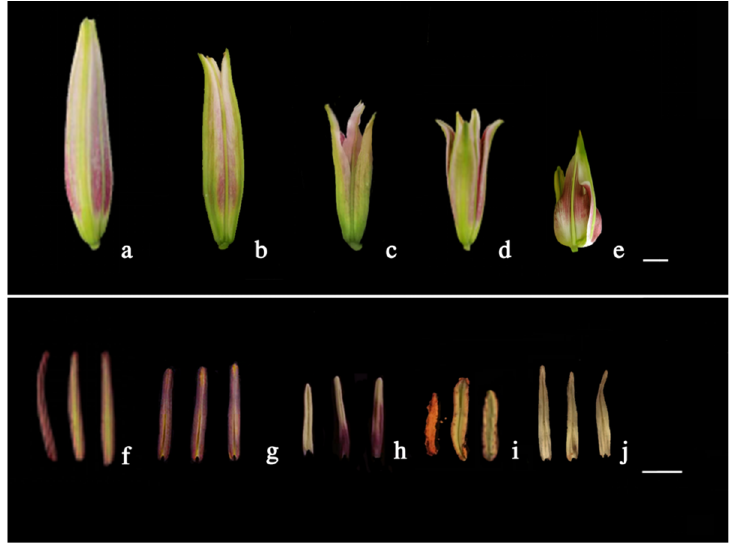
Table 2. E ff ects of di ff erent high temperatures and durations on buds and fertile pollens of ‘Black Beauty’. Figure 3. Flower buds and their corresponding anther morphology on the day of fl owering for the di ff erent treatments and controls. ( a,f ) Control fl ower bud and anthers without any treatment. ( b,g ) the different treatments and controls. ( a , f ) Control flower bud and anthers without any treatment. Flower bud and anthers treated at a high temperature of 40 °C for 4 h. ( c,h ) Flower bud and anthers treated at a high temperature of 42 °C for 6 h (Reduced or no pollen where anthers turn white). ( d,i ) Flower bud and anthers treated with 0.01% concentration of oryzalin. ( e,j ) Flower bud and anthers treated with 0.01% concentration of colchicine(outer petals deciduous) (Bar = 10 mm).